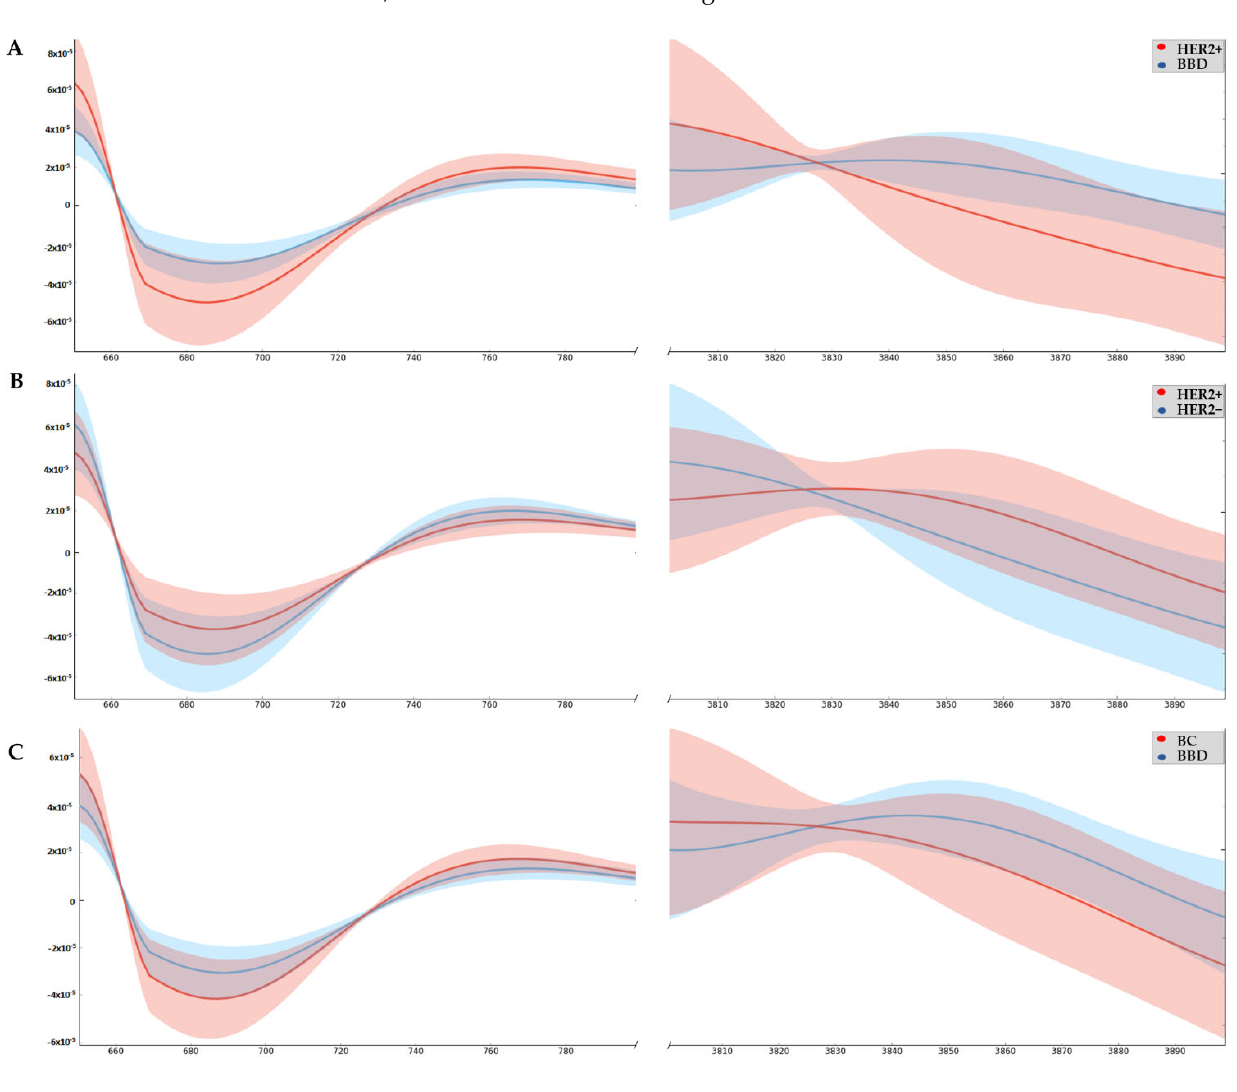
Figure 2. Graph of the second derivative ATR-FTIR. ( A ) Infrared spectrum HER2+ vs. BBD; ( B ) Infrared spectrum HER2+ vs. HER2 − ; ( C ) Infrared spectrum BBD vs. BC. The main wavenumbers detected in the serum, i.e., those with a difference between groups, as well as their vibrational modes and their molecular sources, are described in Table 2. In the region, 706–710 cm − 1 OH (hydroxyl group) out-of-plane bending, CH (hydrocarbon chain) out-of-plane bending and NH (amino group) bending (Amide IV)